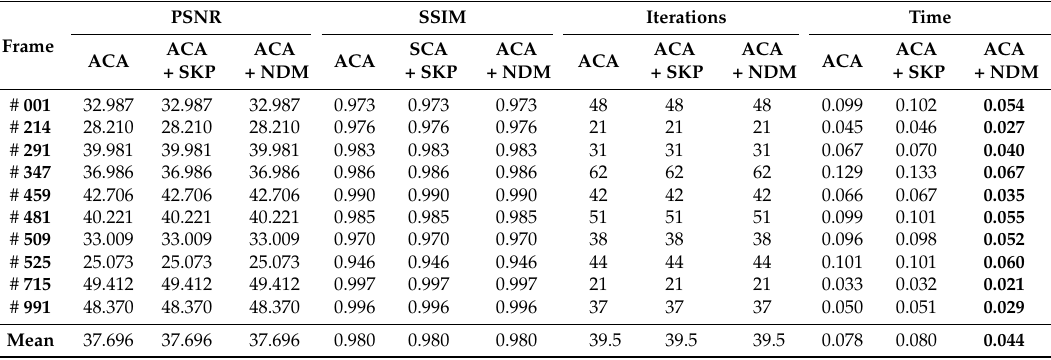
Table A2. Quantitative evaluation results for comparing internal algorithms of the proposed method with von Neumann neighborhood system on the selected Tsukuba Stereo Dataset. The best performance is highlighted in